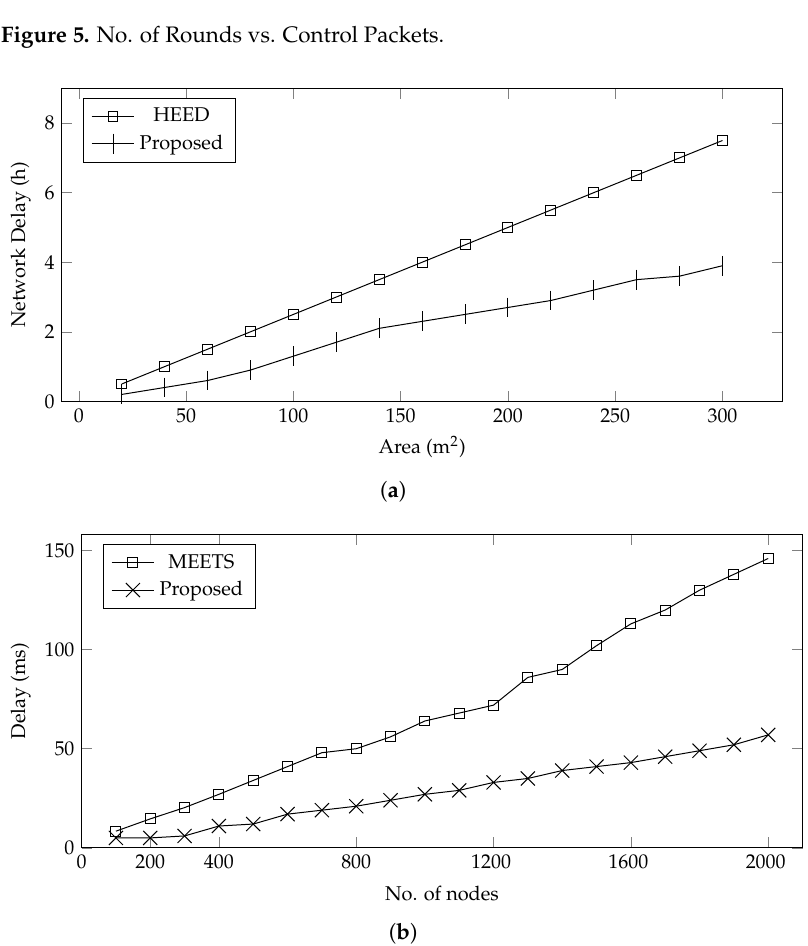
Figure 6. Data collection delay with varying farming area, and data processing delay with varying sensors. ( a ) Data collection delay vs. area; ( b ) data processing delay vs. no. of nodes.